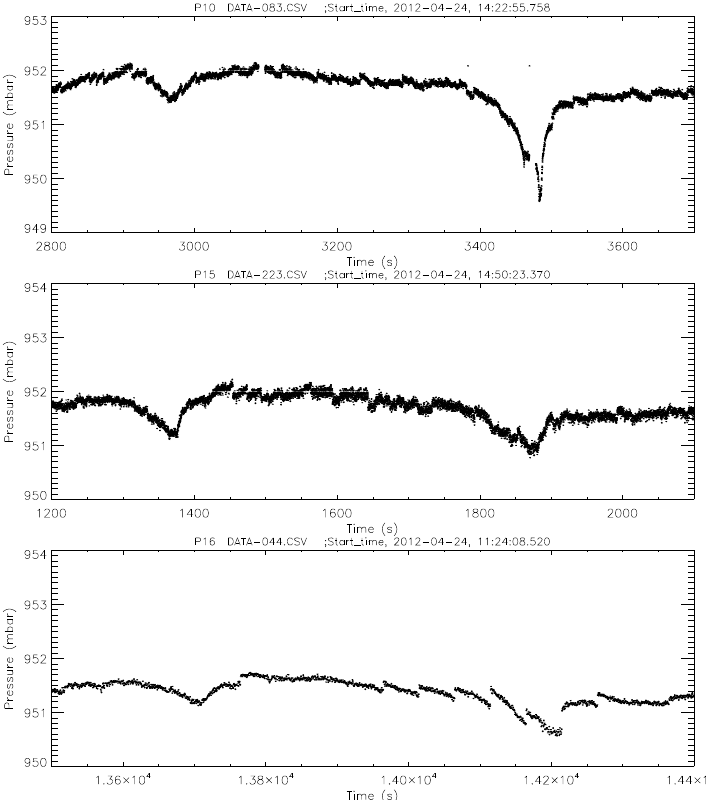
Fig. 11. A pair of dust devils, about 8min apart, observed in all three loggers (shifted to show the coherence of the records). The bottom two plots are essentially synchronous, but the first plot is about 90s earlier in time. Note that the second devil is still detectable at the ∼ 0.5mbar level in the last record (P16) despite the ∼ 0.25mb sawtooth noise (uncorrected in this plot). The second devil evidently passed closest to the P10, where the pressure drop is both sharpest in structure and deepest ( ∼ 1.5mbar); an 8.98s gap exists in the data at 3469.496s, in the middle of the dust devil encounter, suggesting a possible electrostatic